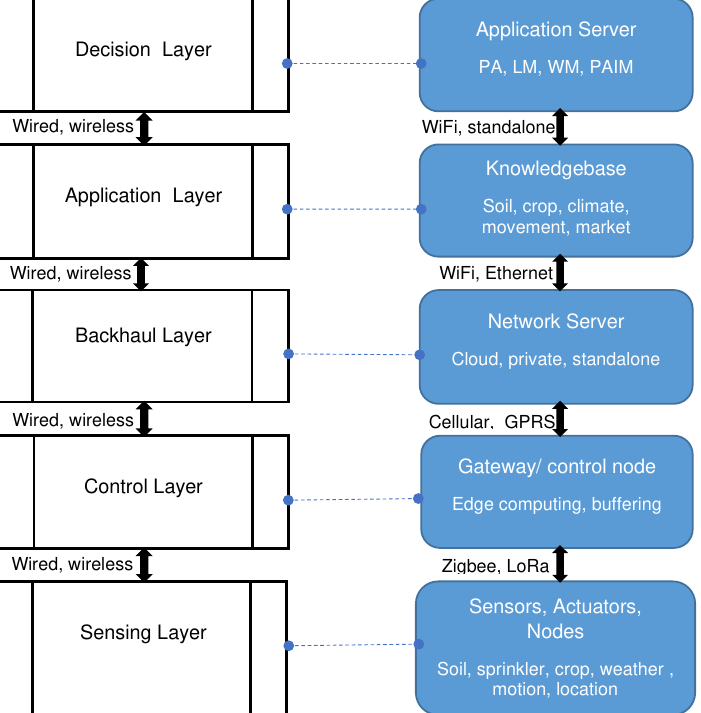
Figure 3. A general Internet of Things (IoT)-wireless Sensor Network (WSN) architecture for agricul- ture applications (PA:Precision Agriculture, LM: Livestock Management, WM: Weather Monitoring, PAIM: Pest and Animal Infestation